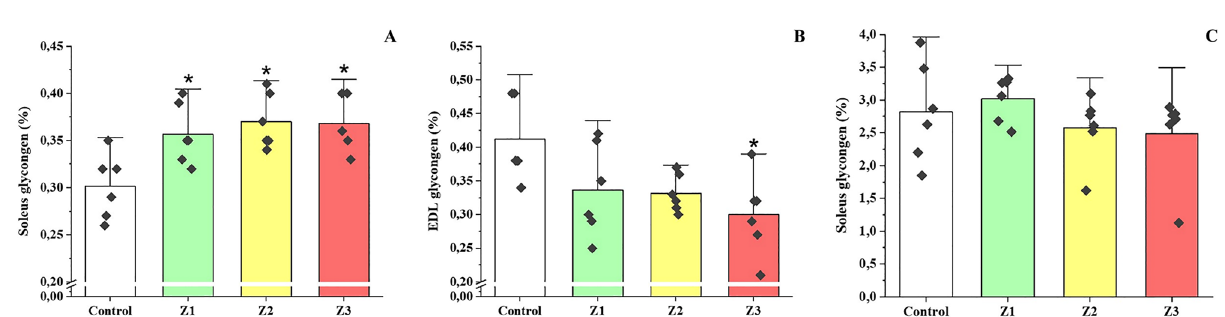
Figure 4. Glycogen concentration expressed in tissue percentage (%) in the soleus ( A ), EDL ( B ), and liver ( C ) muscles of the four experimental groups after five weeks of intervention. Z1 = low intensity training group; Z2 = training group at moderate intensity; Z3 = high intensity training group; * = statistically significant difference for the control (Table 2). The speed was adjusted based on the results of the incremental tests, which means that if performance increased, training speed should also increase; thus, the training load increased and in the 5th week the animals trained with a significantly higher load than in the first two weeks ( p < 0.029) (Fig. 3A). The control group showed no difference in MaxS between the three incremental tests ( p = 0.311) (Fig. 3A). MaxS was higher in IT3 compared to IT1, for groups Z1 ( p = 0.002), Z2 ( p = 0.012) and Z3 ( p = 0.028) (Fig. 3A). The rats’ performance increased for all groups after four weeks, but only for Z1 after two weeks ( p > 0.05) (Fig. 3B). In the soleus muscle, the glycogen concentration ([Glic]) was higher for the three groups submitted to training programs (Z1, Z2, and Z3) compared to the control group ( p < 0.034) (Fig. 4A). In the EDL muscle, the [Glic] were lower only for the Z3 group compared to the control group ( p = 0.021) (Fig. 4B). No significant differences were found in hepatic glycogen between experimental groups ( p > 0.05) (Fig. 4C).